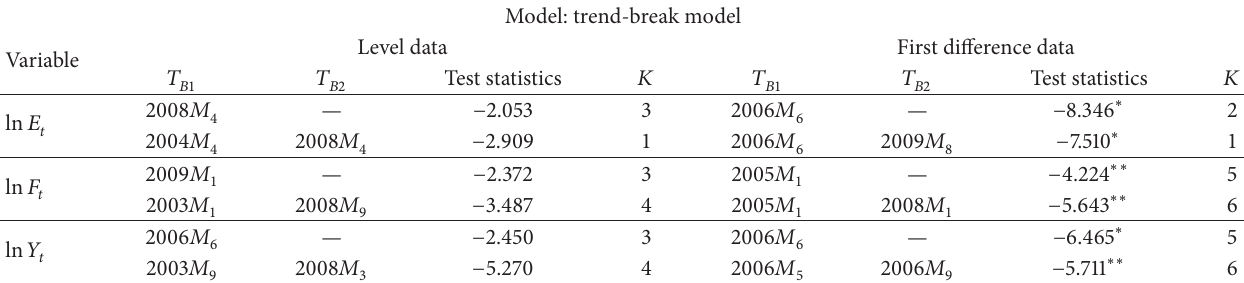
Table 3: Clemente-Montanes-Reyes structural break unit root analysis.